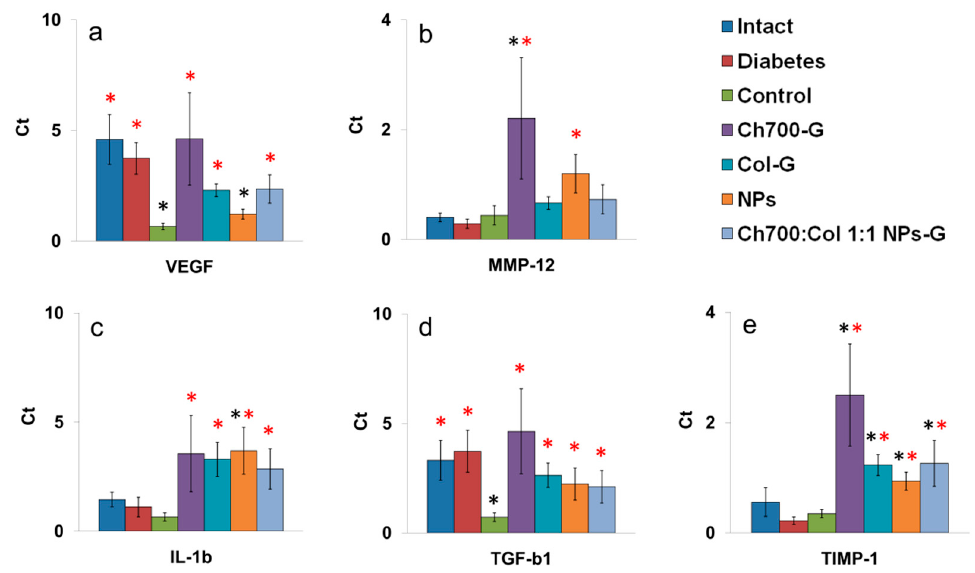
Figure 7. Expression levels of VEGF ( a ), MMP-12 ( b ), IL-1b ( c ), TGF-b1 ( d ), and TIMP-1 ( e ) in skin biopsies of intact mice, diabetic mice without wounds (diabetes), diabetic mice with wounds (control), and diabetic mice with wounds treated by different materials (Ch700-G, Col-G, NPs, Ch700:Col 1:1 NPs-G). The statistical significance was evaluated using the Mann–Whitney test: Black stars— p < 0.05 vs. intact mice; red stars— p < 0.05 vs. diabetic mice with wounds (control).